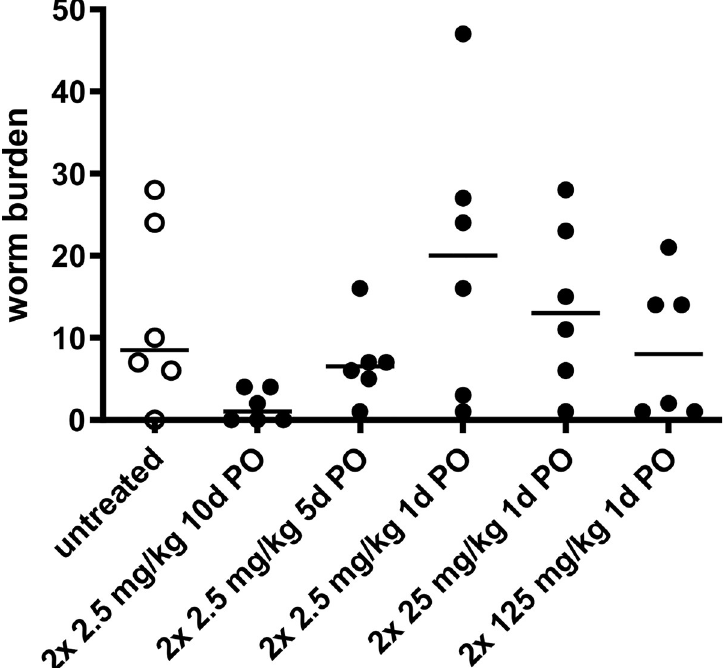
Fig 5. Extended oxfendazole treatment improves L . sigmodontis adult worm clearance. L . sigmodontis adult worm burden 75 dpi in mice naturally infected with L . sigmodontis and treated for one, five or ten consecutive days with oxfendazole starting at 33 dpi at indicated doses. Untreated controls received no oral treatments. Medians of n = 6 per group of a single experiment are shown. Kruskal-Wallis H-test: χ 2 = 10.15, df = 5, p = 0.071.